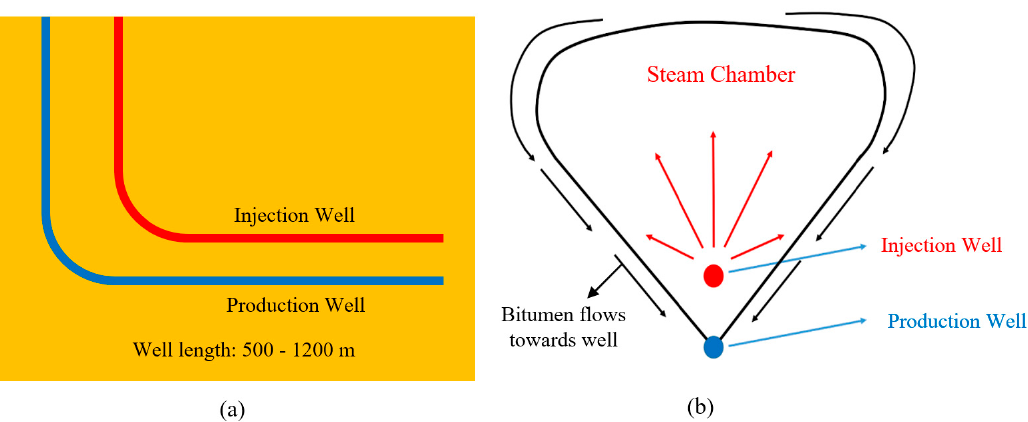
Figure 1. Schematic configuration of ( a ) steam ‐ assisted gravity drainage (SAGD) well pairs and ( b ) steam chamber (modified from Butler [3]).